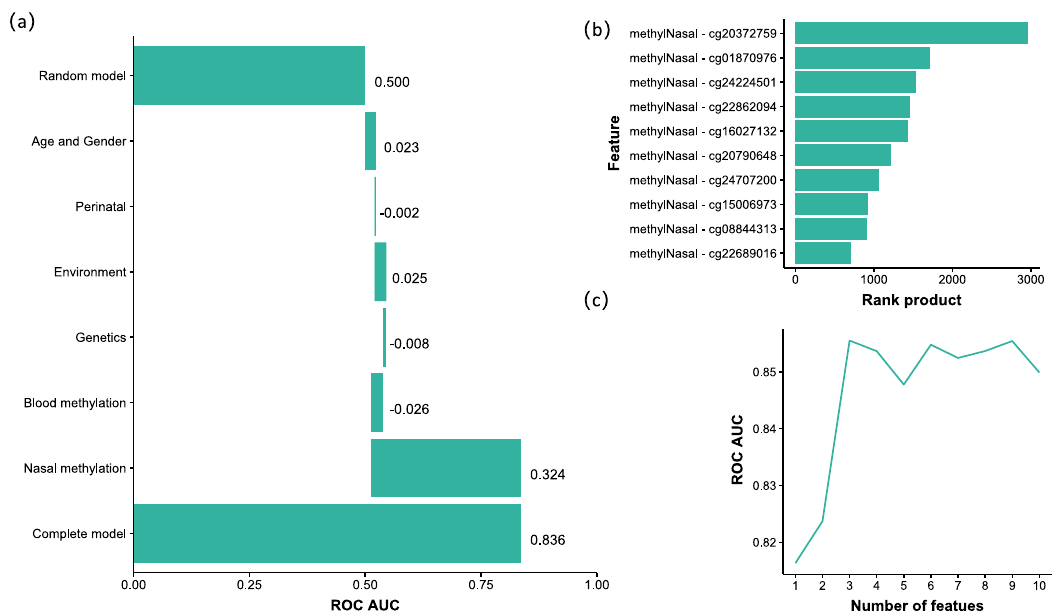
Fig.2|Featureselectionofthedatalayersandfeaturesthatcontributemostto model performance. a Based on the validation performance of an Elastic Net model using a ten-times repeated tenfold cross-validation procedure. Layers were added sequentially: age and gender were added fi rst, then perinatal factors were included in the model, etc.Negative contributions couldoccur when variables had lowpredictivepowerandincreasedmodelover fi